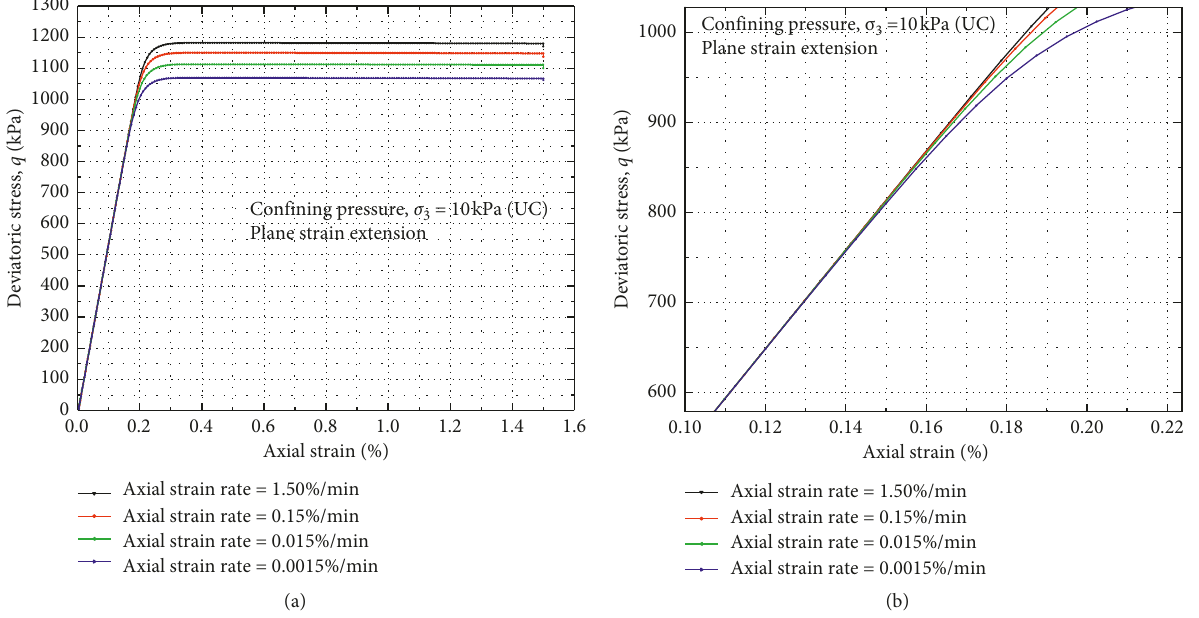
Figure 8: Deviatoric stress versus axial strain (%) for various strain rates under a single confining stress of 10kPa. (a) Displacement control analysis is done. (b) Displacement control analysis is done in the extension direction (zoomed up fig. of Figure 8(a)).